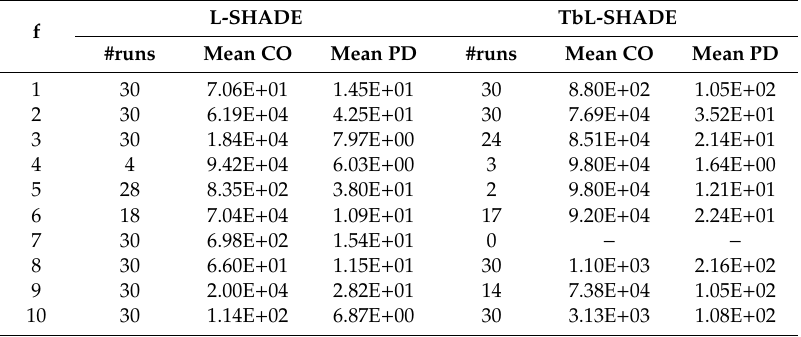
Table 29. Clustering and population diversity of L-SHADE and TbL-SHADE on the CEC2020 in 15 D .